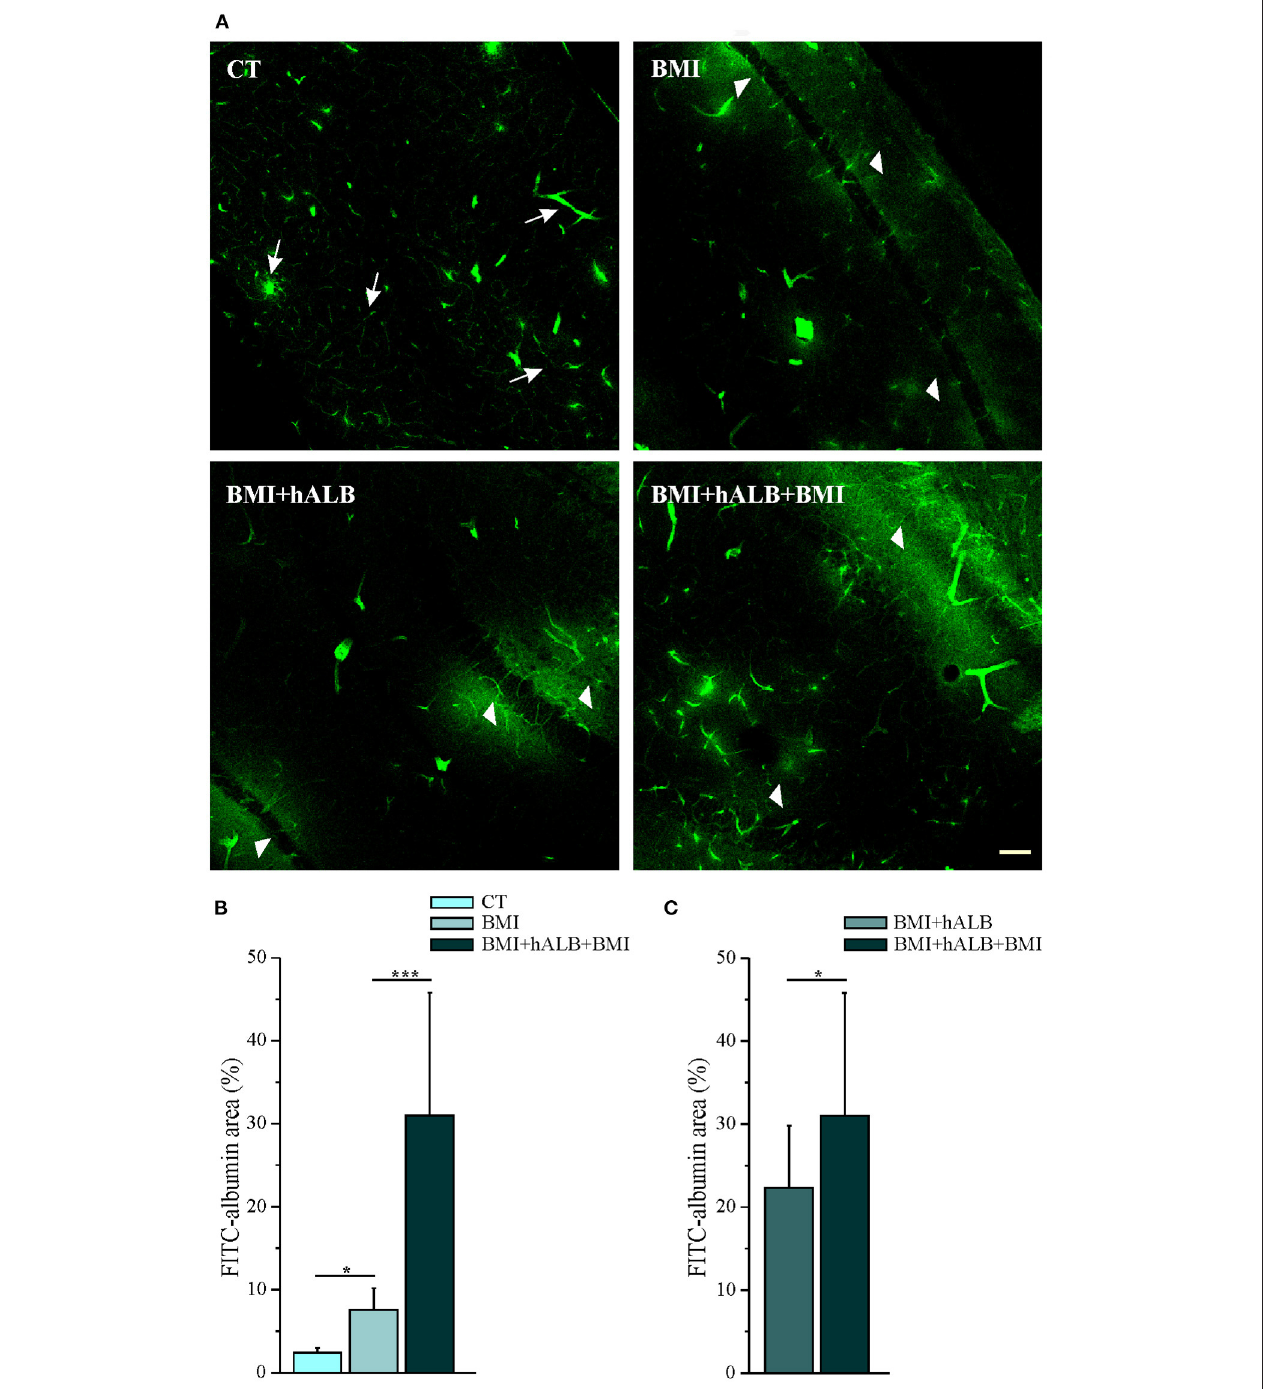
FIGURE 3 | Quantification of parenchymal Fluorescein isothiocyanate (FITC)–albumin leakage. (A) Representative photomicrographs of intraparenchymal FITC–albumin signal in the limbic area in control solution (top, left), BMI (top, right), BMI + h-ALB (bottom, left), and BMI + h-ALB + BMI (bottom, right) treated brains. Control sections show intraluminal signal with scattered perivascular spots (white arrow). Areas of FITC–albumin parenchymal extravasation around vessels (white arrowheads) after the second pulse of BMI alone or co-perfused with h-recombinant albumin, showed as FITC–albumin parenchymal leakage is broader after the application of protocol C and D (see Figure 1 ). (B,C) Quantification of parenchymal FITC–albumin leakage in the experimental conditions. FITC-albumin leakage has been evaluated as spot area (number of pixels) and it is expressed as percentage of values vs. control experiments * p < 0.05; *** p < 0.001 with ANOVA and Student t -test. Calibration bar = 100 µ